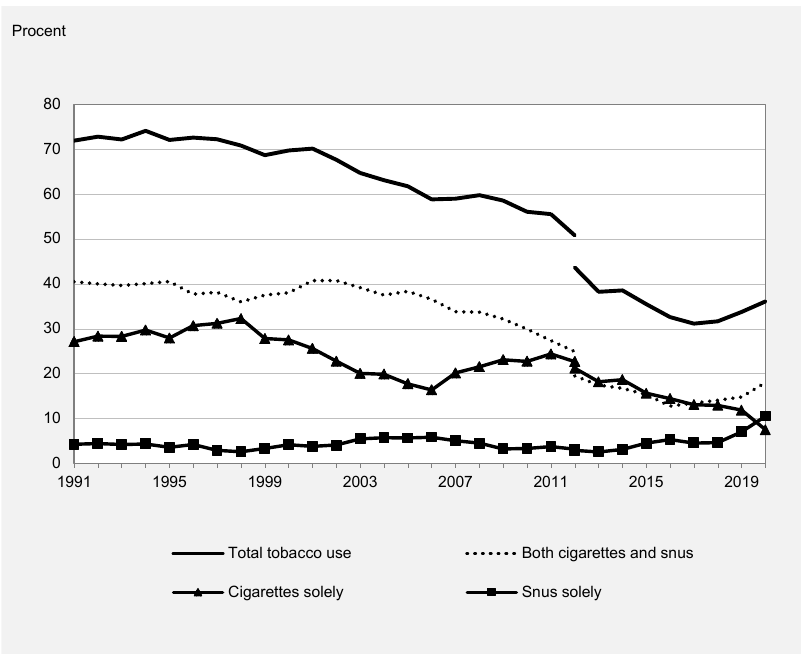
Figure 1. Use of tobacco among 9th graders in Sweden, 1991–2020.